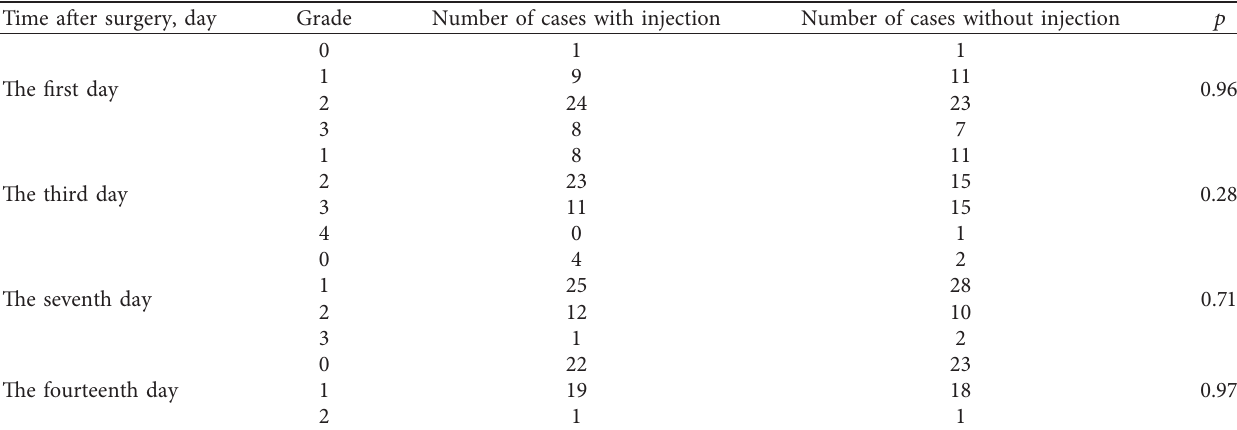
Table 2: Frequency distribution of edema grade on days 1, 3, 7, and 14 after injection, classified into those cases of the patients’ faces that received the injection and those cases of the patients’ faces that did not receive the